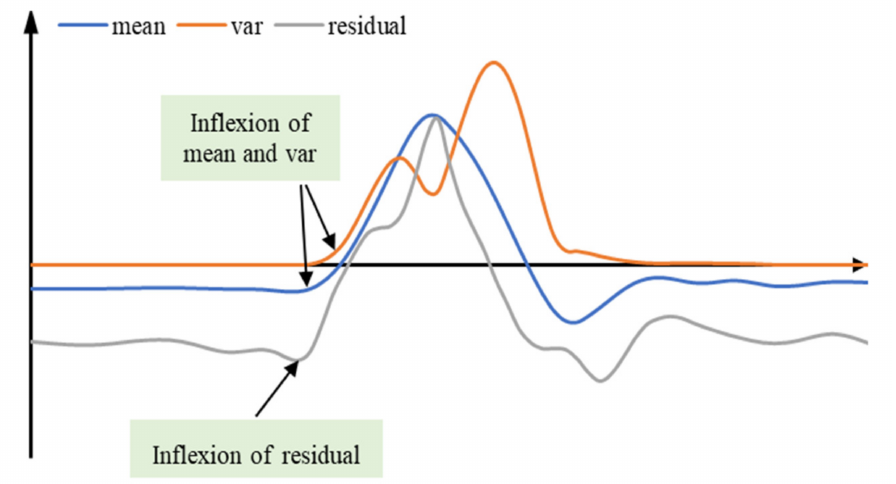
Figure 4. Residual and the corresponding mean and variance